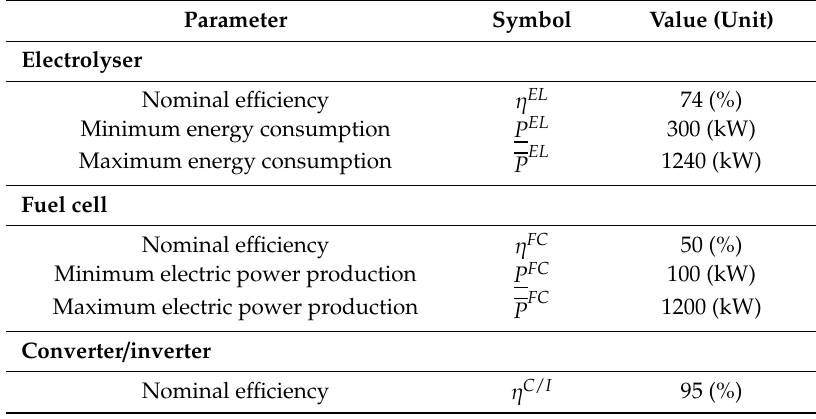
Table 4. Modelling parameters for the hydrogen storage system (HSS)